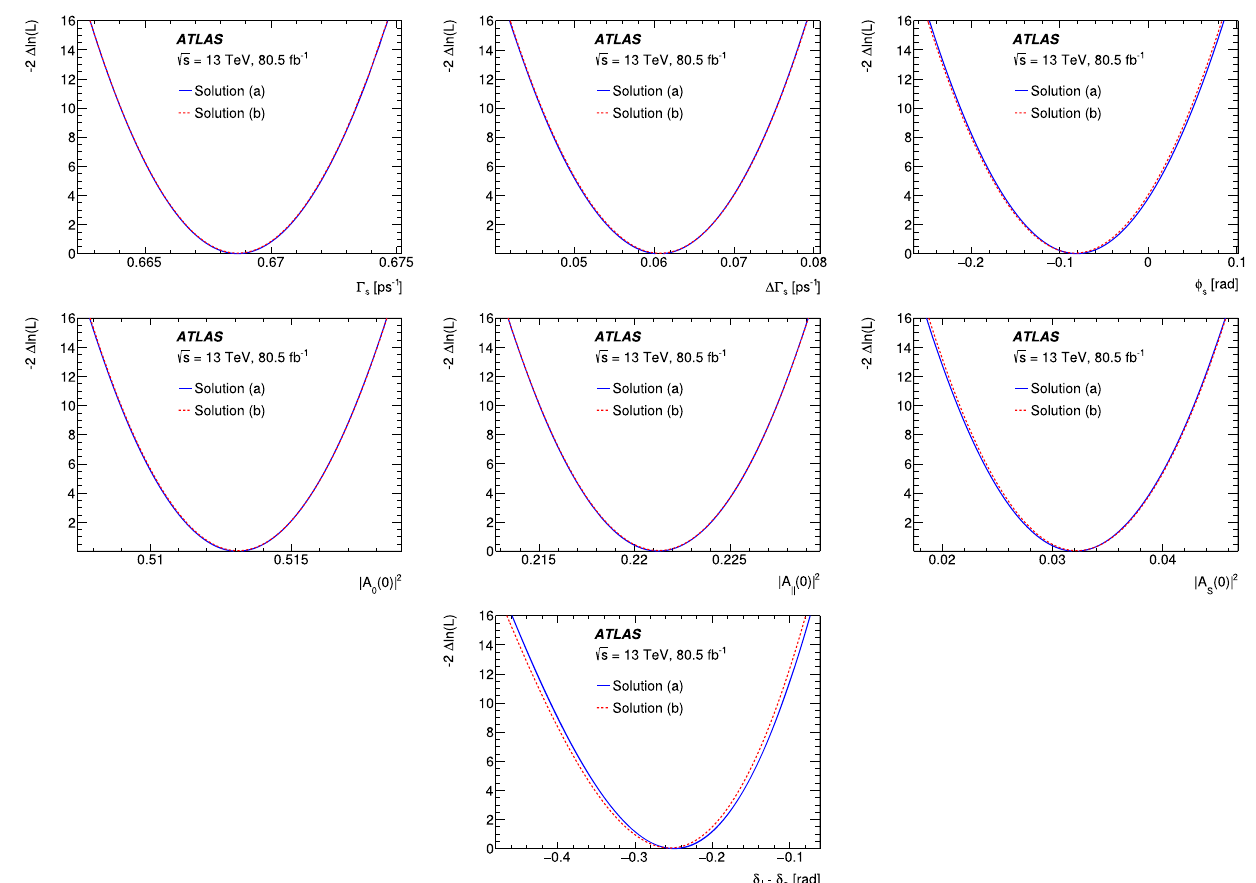
Fig. 10 1D log-likelihood scans of all other variables of the fit for the solution (a) (blue) and the solution (b) (dashed red). The variable on the vertical axis, − 2 (cid:5) ln ( L ) = 2 ( ln ( L a ) − ln ( L i )) , is the difference